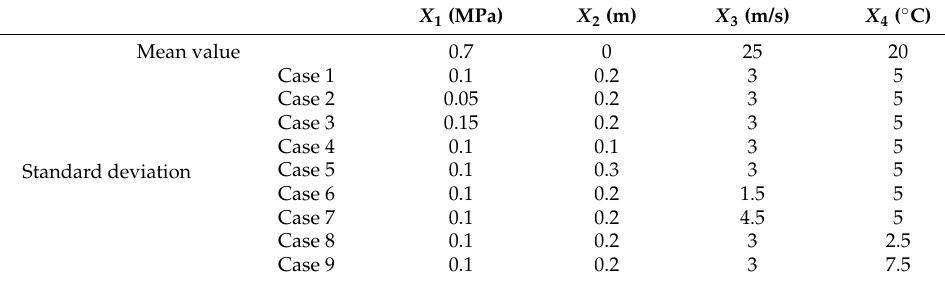
Table 6. Random variables with different standard